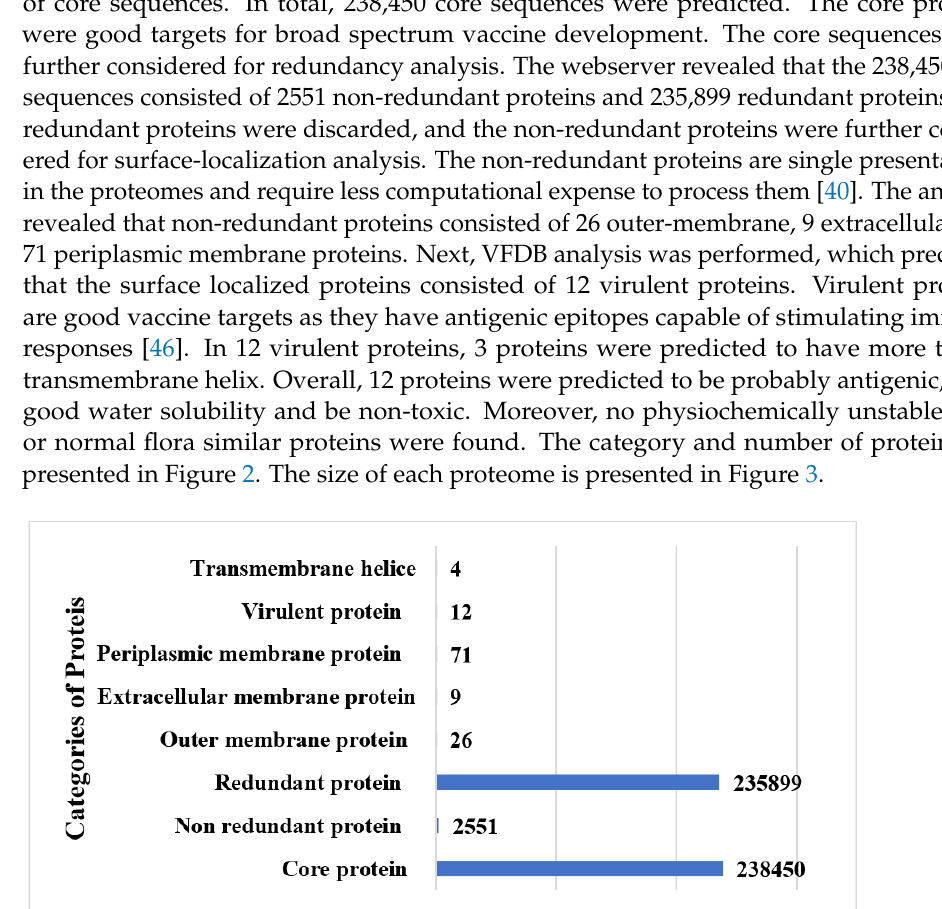
Figure 3. Pan-core plot. The number of fully sequenced proteomes used are plotted on the X-axis while gene families are plotted against each proteome on the Y-axis. 3.2. Epitopes Prediction B and B-cell derived T-cell epitopes were predicted from the shortlisted 11 proteins given in Table 1. The predicted B-cell epitopes were further utilized for T-cell epitopes. The predicted MHC-I and MHC-II epitopes are tabulated in Table S1 with least percentile scores. The common and lowest percentile score epitopes were opted for downward anal- yses.